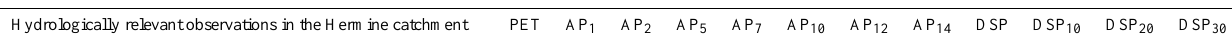
Table 1. Links between surrogate measures for AMCs and hydrologically relevant observations from other studies focusing on the Hermine catchment. “ ×× ” means that a strong significant correlation was found, “ × ” means that rather weak correlations were found, and blanks mean that no significant correlations were found. Significant correlations identified with surrogate measures for AMCs Hydrologically relevant observations in the Hermine